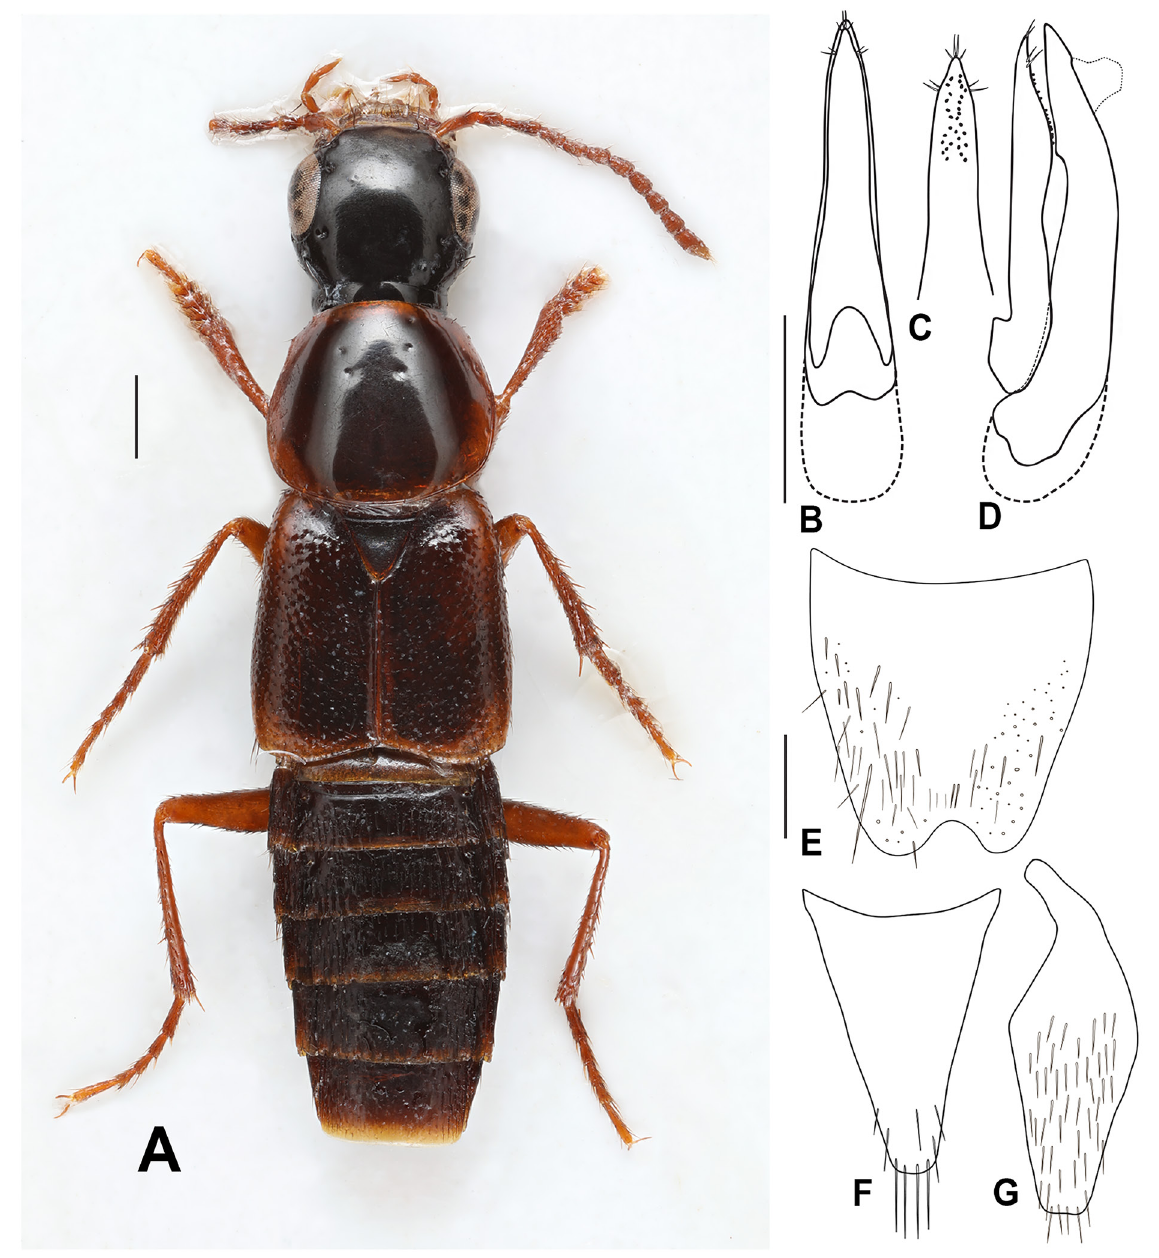
Fig. 3. Quedius viator sp. nov., holotype (ZIN). A . Habitus. B–D . Aedeagus. B . From parameral side. C . Apical portion of paramere (underside). D . Lateral view. E . Sternite VIII. F . Tegite X. G . Sternite IX. Scale bars: A = 1 mm; B–G = 0.5